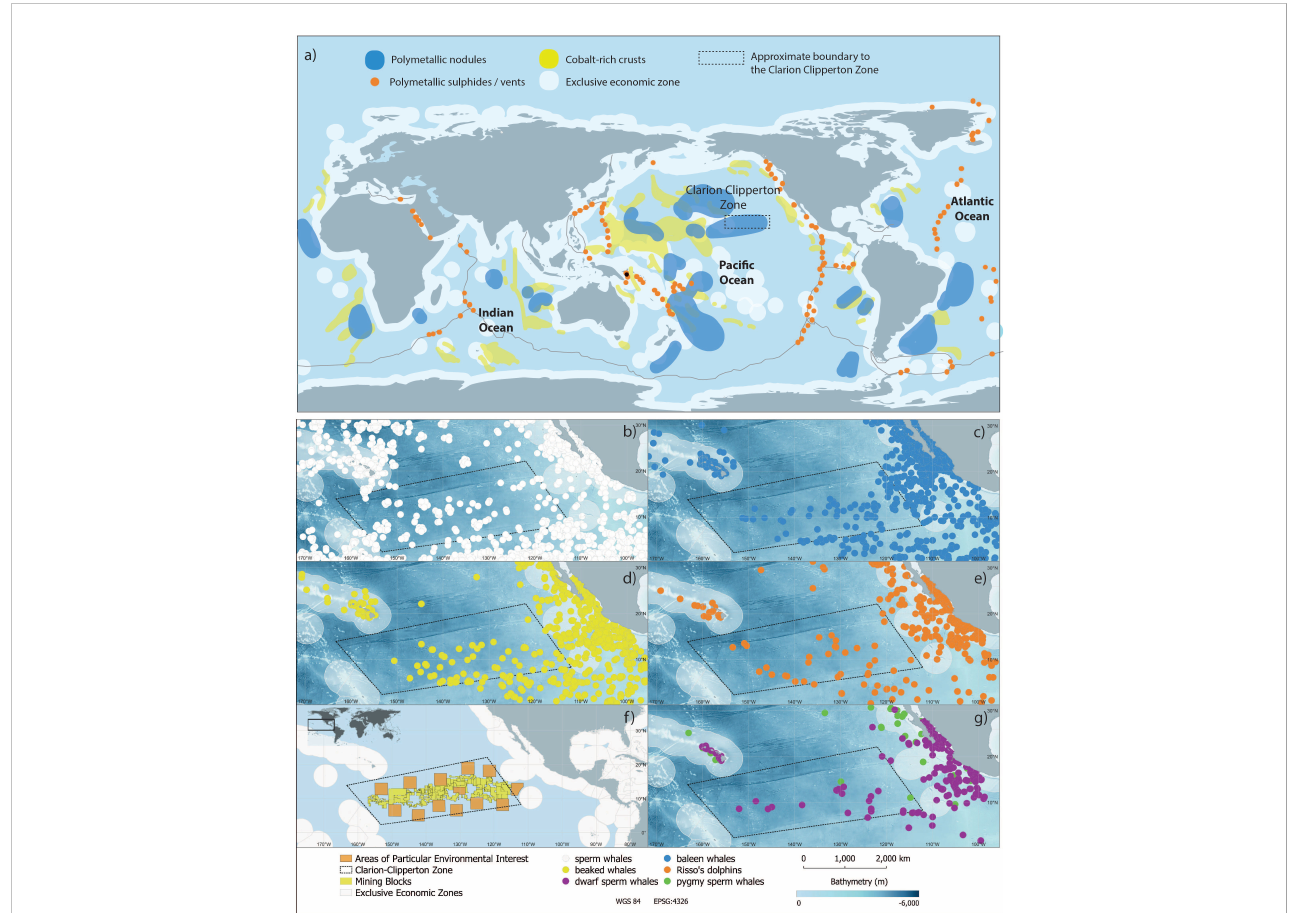
FIGURE 1 Deep seabed mining areas and with a focus on the spatial overlap of the Clarion Clipperton Zone (CCZ) with data on cetacean occurrence as reported in the OBIS-SEAMAP (https://seamap.env.duke.edu/) repository. (A) A global map of areas of the seabed with known regions of mineral resources. (Source: Miller et al., 2018. Licensed for use under Creative Commons: http://creativecommons.org/licenses/by/4.0/). (B) sperm whale ( Physeter macrocephalus ) occurrence (in white) (C) occurrence of baleen whales (in blue), (D) beaked whale occurrence (in yellow), (E) Risso ’ s dolphin ( Grampus griseus ) occurrence (in orange), (F) the rectangular box marks the extent of cetacean data accessed from OBIS-SEAMAP and approximate location of the boundaries of the CCZ, mining blocks and areas of particular environmental interest and (G) occurrence of Kogia spp. ( Kogia sima in dark green, Kogia breviceps in purple). Note that occurrence information include data from multiple sources (see supplementary information for more details). Baleen whale data refer to the following species: blue ( Balaenoptera musculus ), fi n ( Balaenoptera physalus ), humpback ( Megaptera novaeangliae ), gray ( Eschrichtius robustus ), Bryde ’ s ( Balaenoptera edeni ) and minke whales ( Balaenoptera acutorostrata ) and unidenti fi ed baleanopterids. Beaked whale data refer to the following species: Cuvier ’ s ( Ziphius cavirostris ), Longman ’ s ( Indopacetus paci fi cus ), Blainville ’ s ( Mesoplodon densirostris ), pygmy ( Mesoplodon peruvianus ) and Baird ’ s ( Berardius bairdii ) and unidenti fi ed beaked whales. All depth data are derived from GEBCO